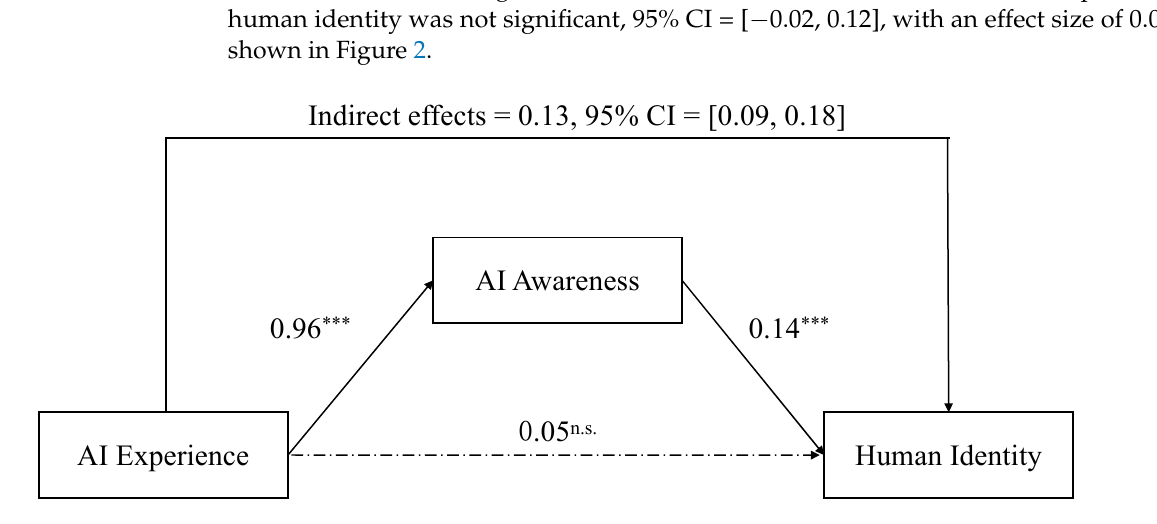
Figure 2. Mediating effect of artificial intelligence awareness. Note: * p < 0.05, *** p < 0.001; n.s. indicates not significant